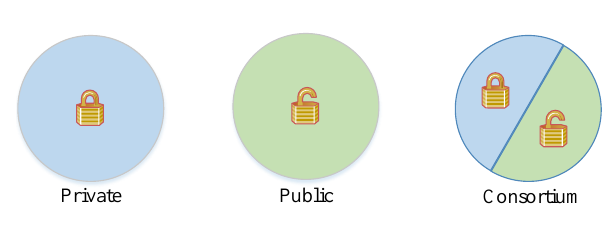
Figure 3. Types of keys in blockchain